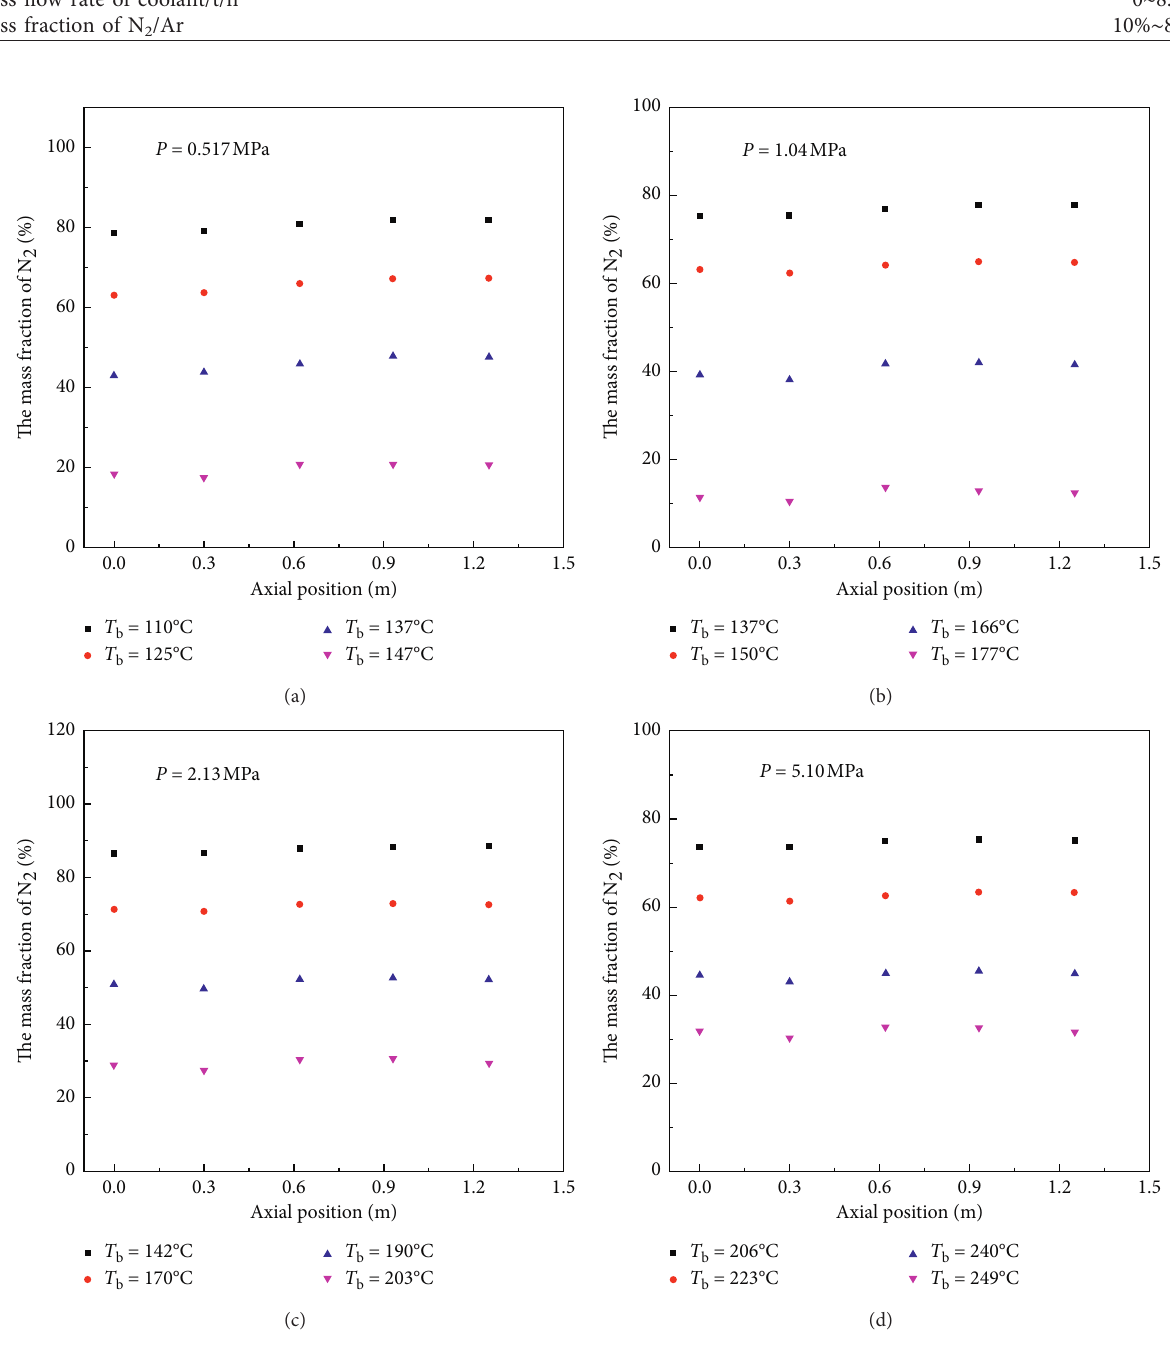
Figure 3: The distributions of N P � 0.517MPa. (b) P � 1.04MPa. (c) P � 2.13MPa. (d) P � 2 in the axial direction. (a)